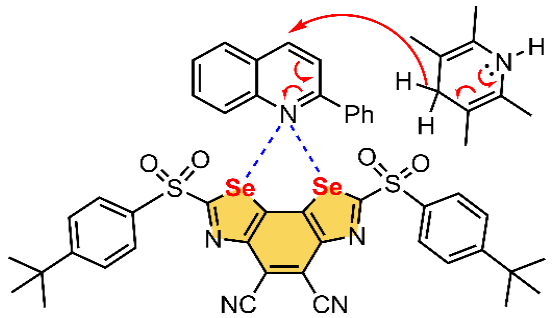
Figure 14. Schematic representation of the expected transition-state stabilization by a bifurcated Se ChB, involving compound 24 .